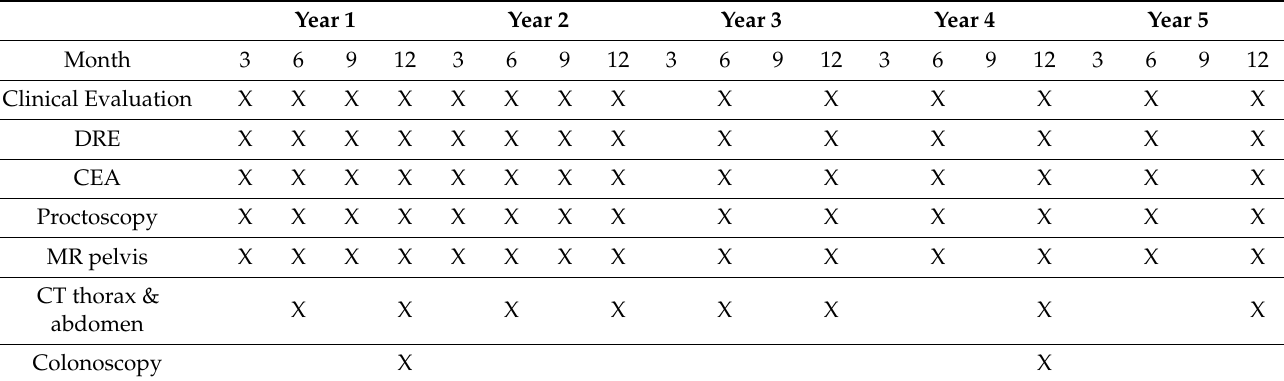
Table 2. Follow-up scheme for non-operative management